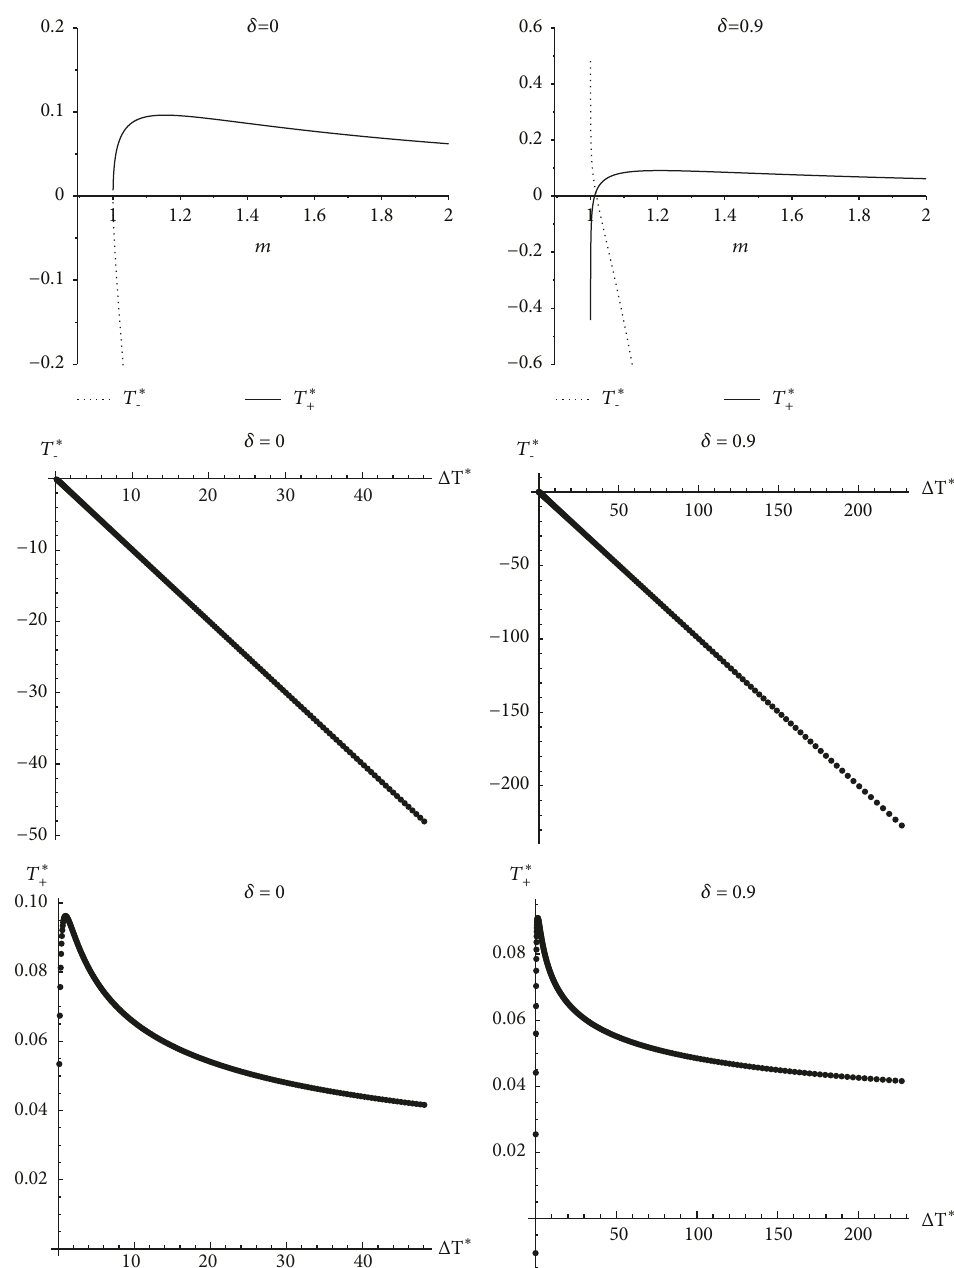
Figure 2: Diagram of 𝑇 ∗ ± is plotted against 𝑚 and Δ𝑇 ∗ for 𝛿 = 0 and 𝛿 = 0.9 .